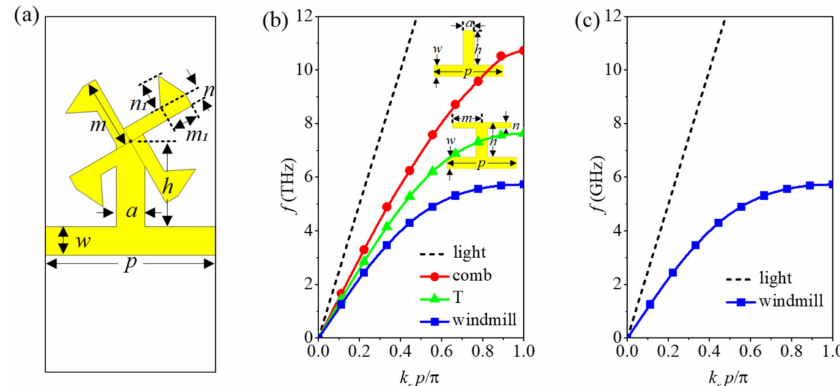
Figure 1. Waveguide unit structure and dispersion relations. ( a ) Terahertz windmill-shaped SSPP unit, where the parameters are set as: p = 6 µ m, w = 1 µ m, a = 1 µ m, h = 3 µ m, m = 2.5 µ m, n = 0.5 µ m, m 1 = 1 µ m, and n 1 = 1; ( b ) comparison of the terahertz dispersion curves for the fundamental SSPP among the comb-, T-, and windmill-shaped unit; ( c ) the microwave dispersion relation for the fundamental SSPP of the windmill-shaped unit with all dimensions scaled up by 1000 times from µ m to